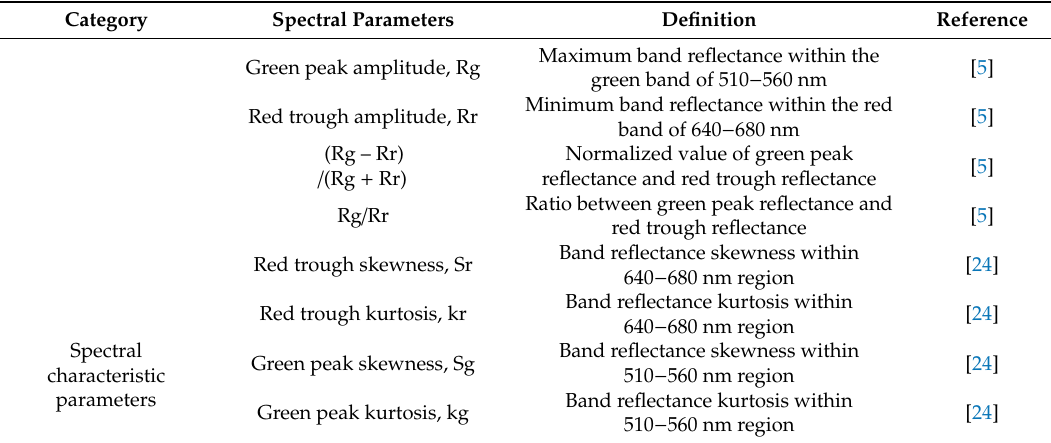
Table 3. Indices used in the study for spectral monitoring of